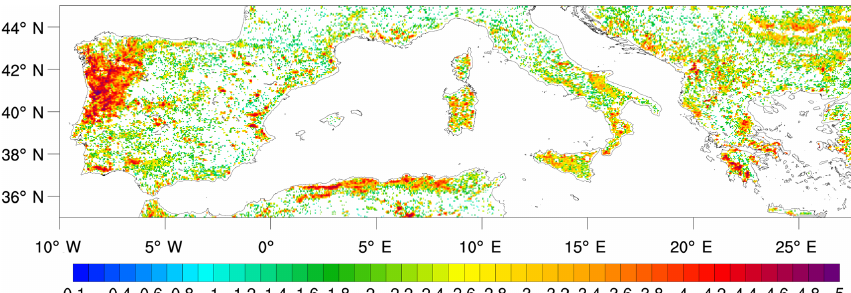
Figure 5. Geographical distribution of total energy released by fire recorded during the calibration period (2004–2016). The colour bar indicates the values of the decimal logarithm of the total energy (log 10 E , with E inGJ).